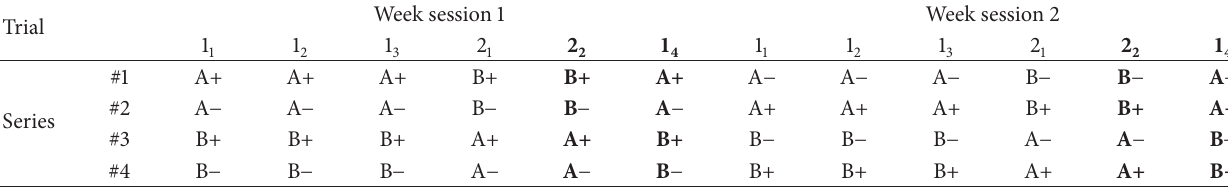
Table 1: Experimental block design for the two